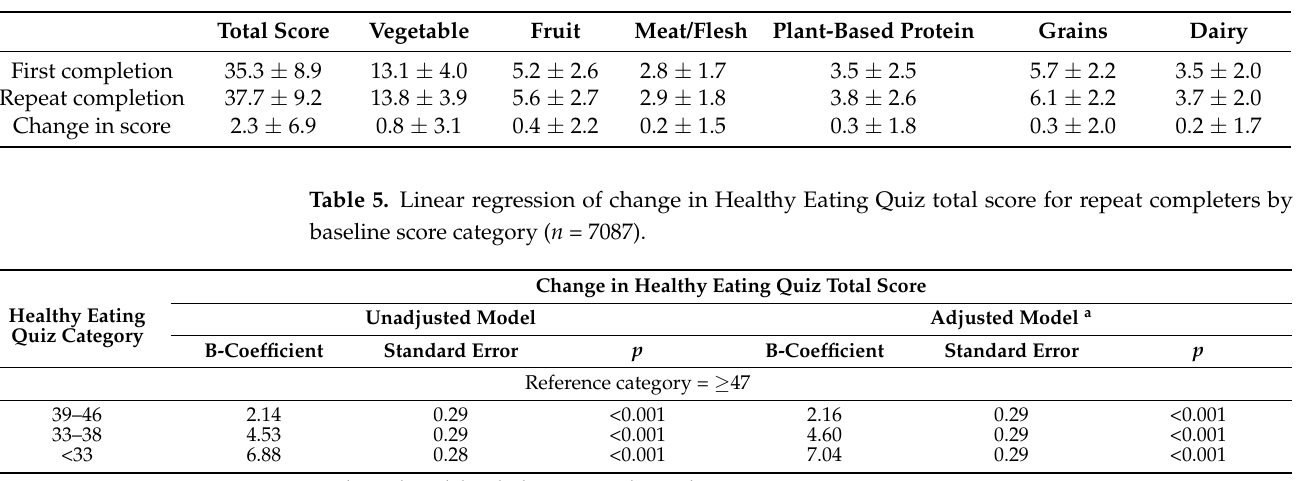
Table 4. Healthy Eating Quiz total and sub-scale scores for repeat completers ( n = 7087).